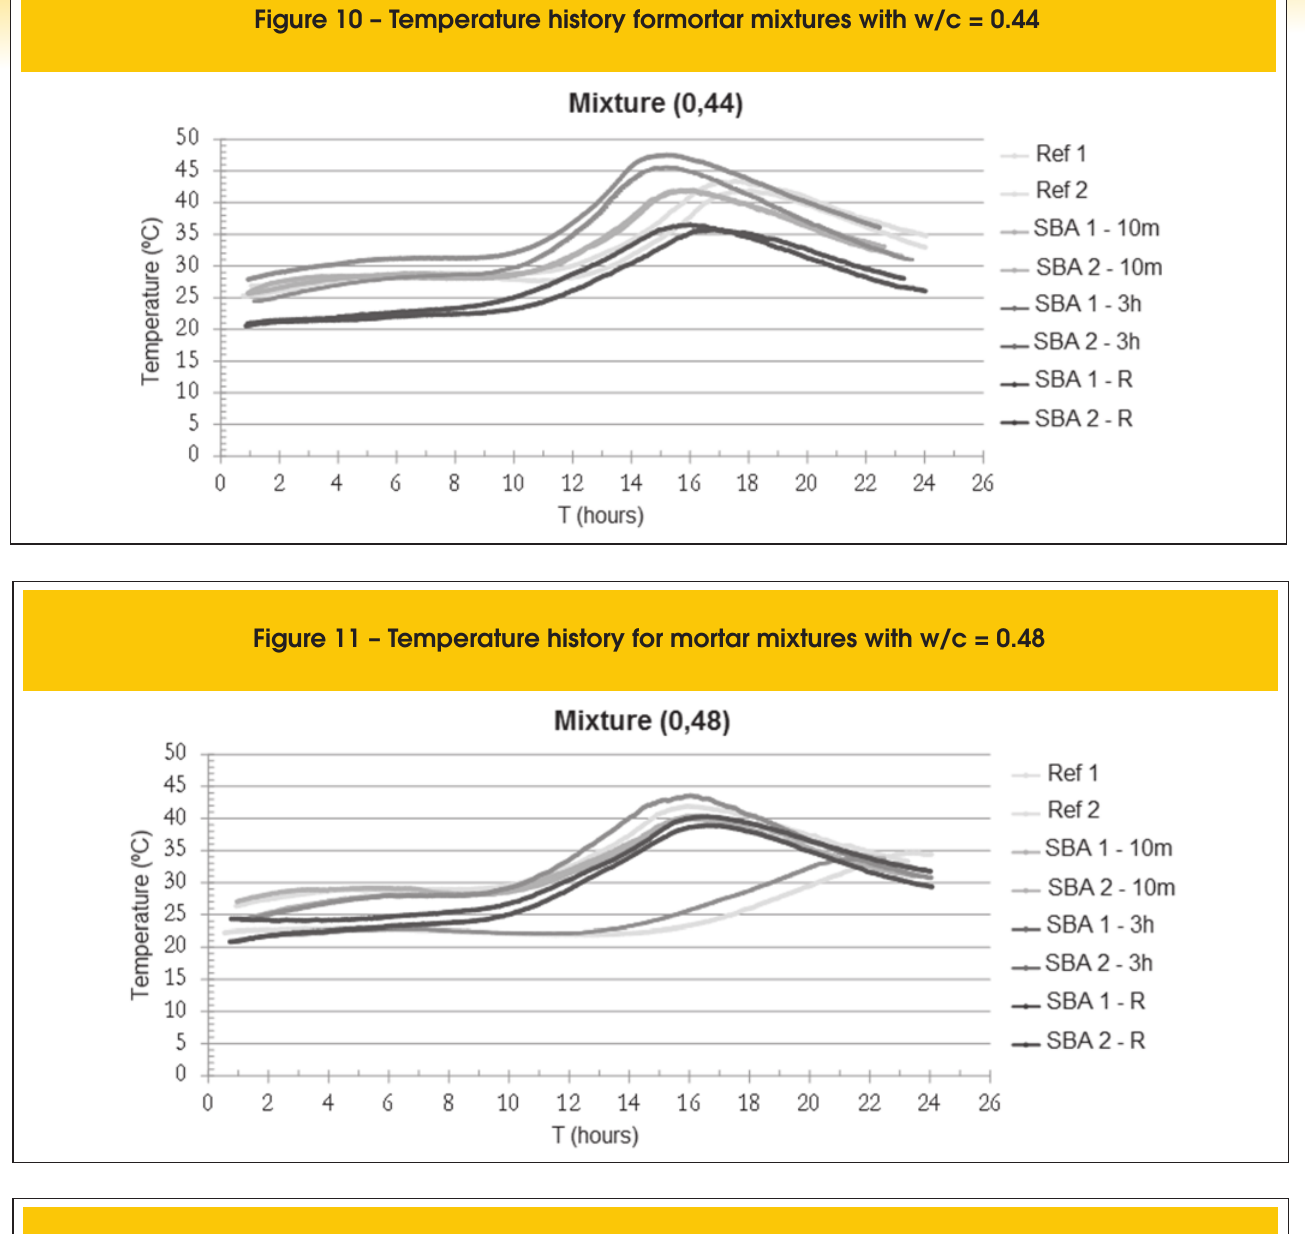
Figure 12 – Temperature history for mortar mixtures with w/c =